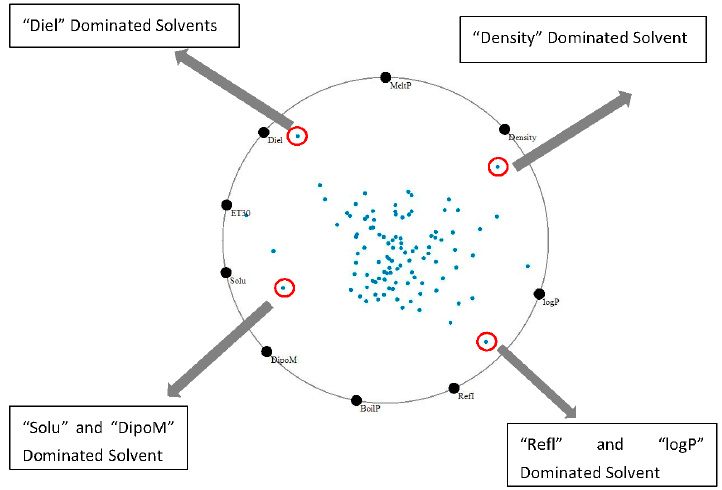
Figure 13. RadViz Deluxe visualizing the solvents data.